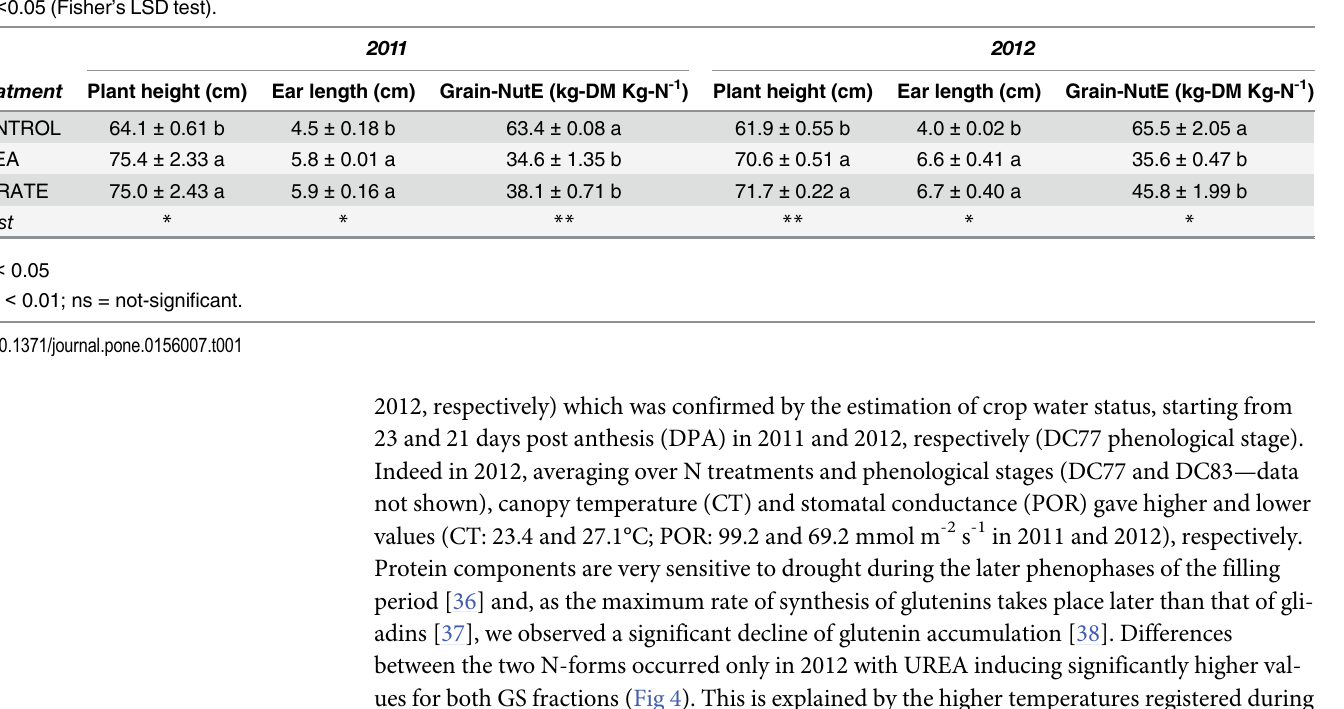
ues for both GS fractions (Fig 4). This is explained by the higher temperatures registered during